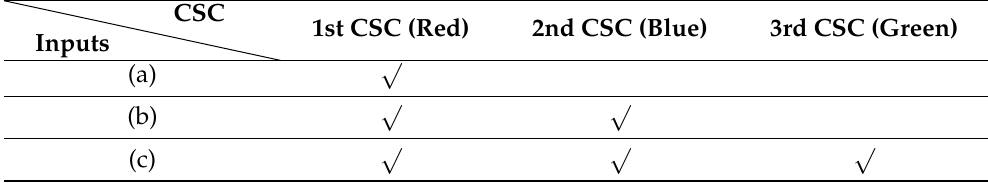
Table 2. Comparison with different convolutional skip connections in each input (for the color of CSC module, refer to Figure 3).